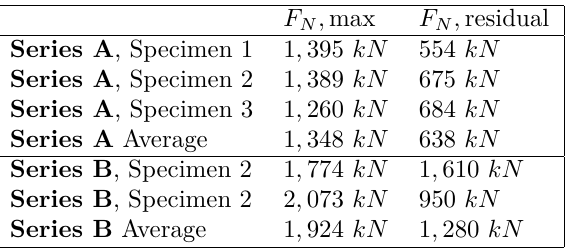
Table 5. Results of the experimental